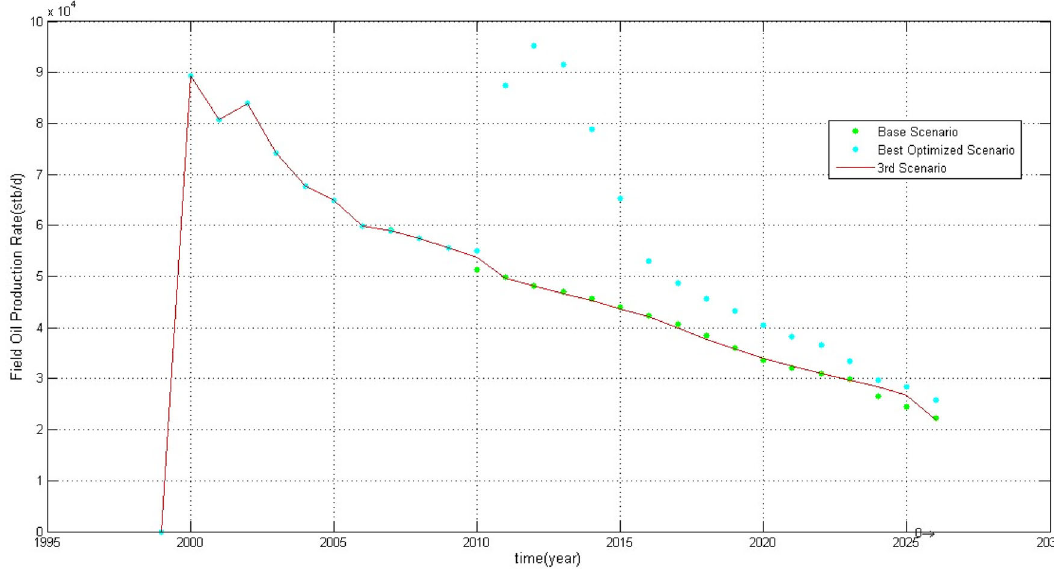
Fig. 7 Field production rate of third